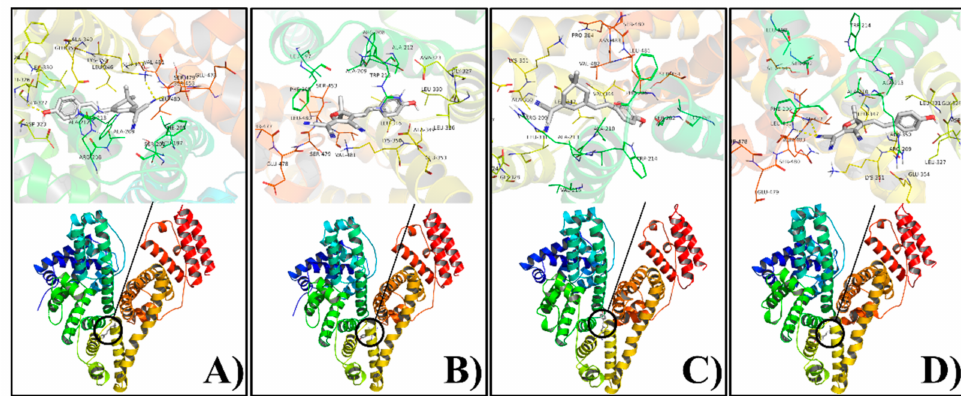
Figure 3. Molecular docking of DCI-OH ( A , C ) and TCF-OH ( B , D ) with albumins (( A , B ) for BSA; ( C , D ) for HSA). Upper: amino acid residues involved; Lower: cartoon model representing DCI-OH and TCF-OH as stick while HSA and BSA are represented by ribbon model. Table 1. Molecular docking parameters were obtained from Albumin-DCI-OH or TCF-OH interaction. Host Guest Amino Acid Residues Forces